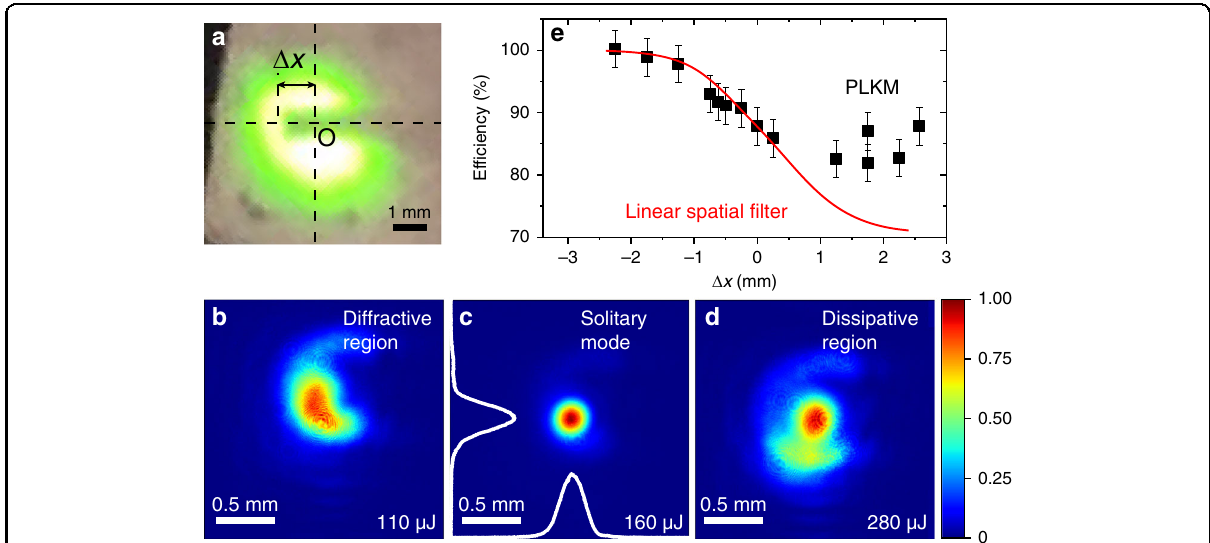
Fig. 5 High-ef fi ciency mode self-cleaning under the resonant conditions. a Camera picture of the modulated laser beam after the beam blocker for Δ x ≈ 1.25 mm. O is the centre of the beam pro fi le, and Δ x is the transverse blocker position. b – d The output beam pro fi les measured in the far fi eld for the spatially modulated input beam shown in ( a ). in the diffractive region, at the solitary mode and in the dissipative region, respectively. The lines in ( c ). represent the horizontal and vertical beam pro fi les in the solitary mode. e The fi ltering ef fi ciency as a function of the blocker position ( Δ x ) for the PLKM resonator and a linear spatial fi